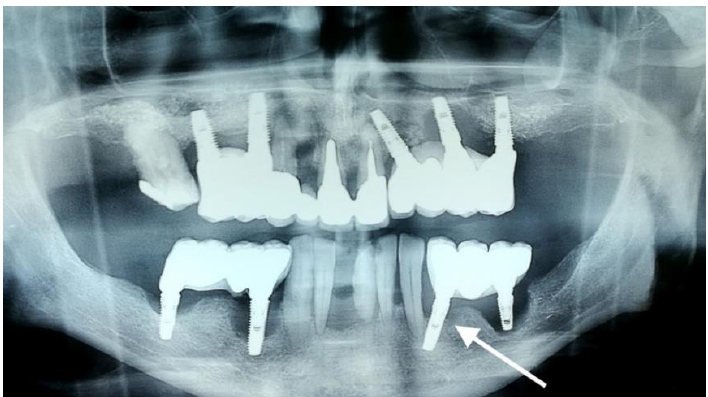
Figure 3. OPG radiography revealing peri-implantitis-affected areas. Quadrants 3 and 4 show bone loss extended to the apical segments of the implants, while quadrants 1 and 2 show a goblet-shaped bone loss. The studied implant is marked with an arrow.